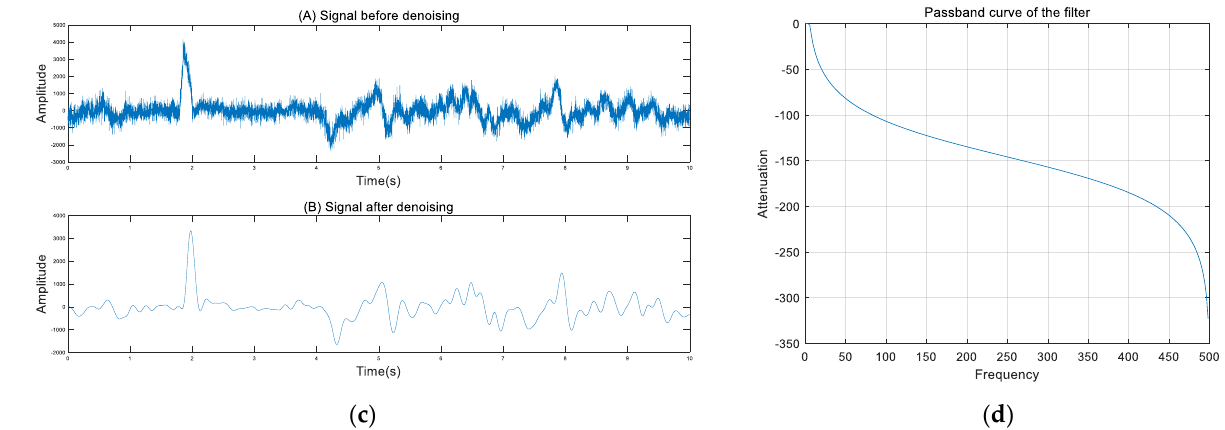
Figure 8. ( a ) Multi-channel signal before filtering; ( b ) Multi-channel signal after filtering; ( c ) Single-channel signal before and after filtering; ( d ) Pass-band curve of the filter.